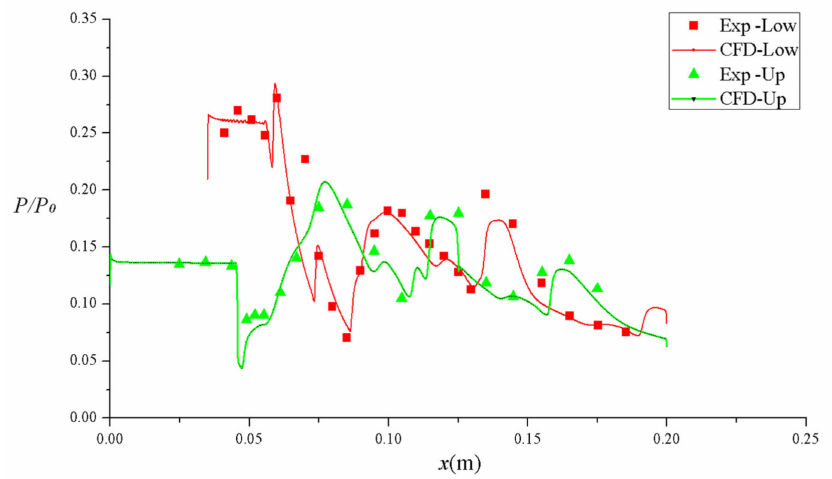
Figure 5. Comparison of the wall pressure.